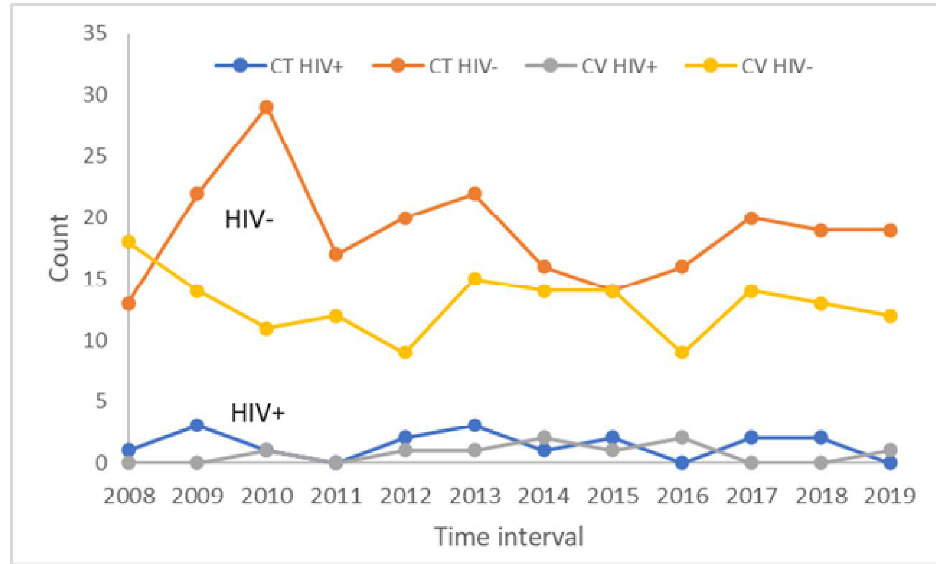
Figure 1. Line chart showing comparative trends over time for HIV-negative and HIV-positive newborns in Constanta and Craiova, Regional Centers (RCs). CT HIV+ = HIV-positive newborns from Constanta RC; CT HIV− = HIV-negative newborns from Constanta RC; CV HIV+ = HIV-positive newborns from Craiova RC; CV HIV− =HIV-negative newborns from Craiova RC. The Apgar score in the case of HIV-positive newborns performed at birth was between 6 and 10, with a median value of 8 (IQR = 1) for Constanta RC and between 7 and 10, with a median value of 8 (IQR = 1) for Craiova RC, but without any statistical significance between the two groups ( p = 0.544, Table 1). Table 1. Anthropometric parameters and Apgar score of HIV-positive newborns. Infant